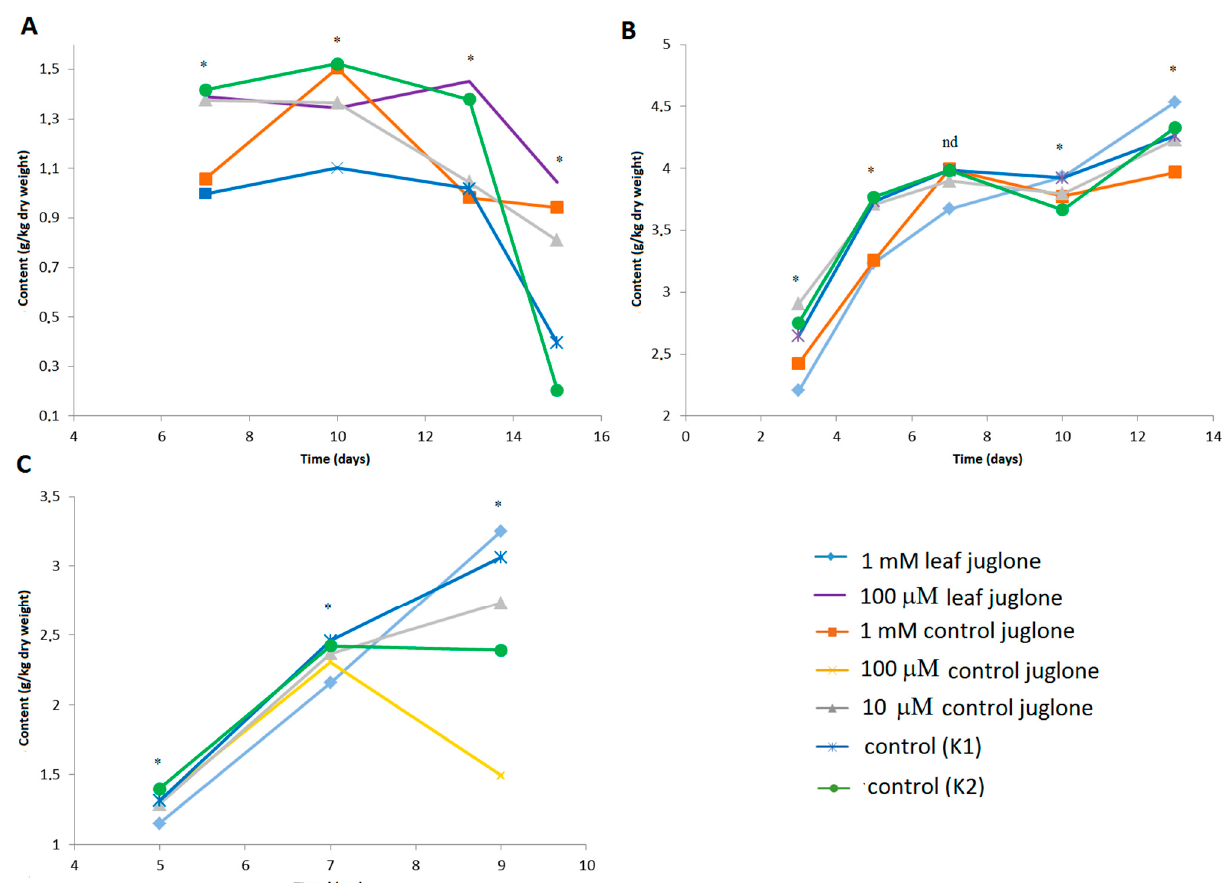
Figure 4. Effects of control juglone and known leaf extract juglone treatments on content of the amino acid phenyl butryryl glutamine ( A , B ) identified in S. lycopersicum ( A ) and L. culinaris ( B ), and the phenyl glucoside derivative 4- hydroxyphenylaoyl glucoside in L. sativa ( C ). K1, extraction medium (vehicle); K2, water; *; are significantly different ( p < 0.05); nd, not significantly different.